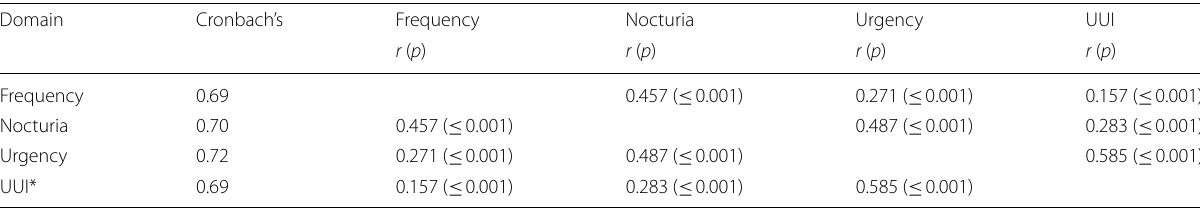
Table 3 Internal consistency (Cronbach’s α ) and interdomain association by Spearman’s correlation coefficient in the BPH group Domain